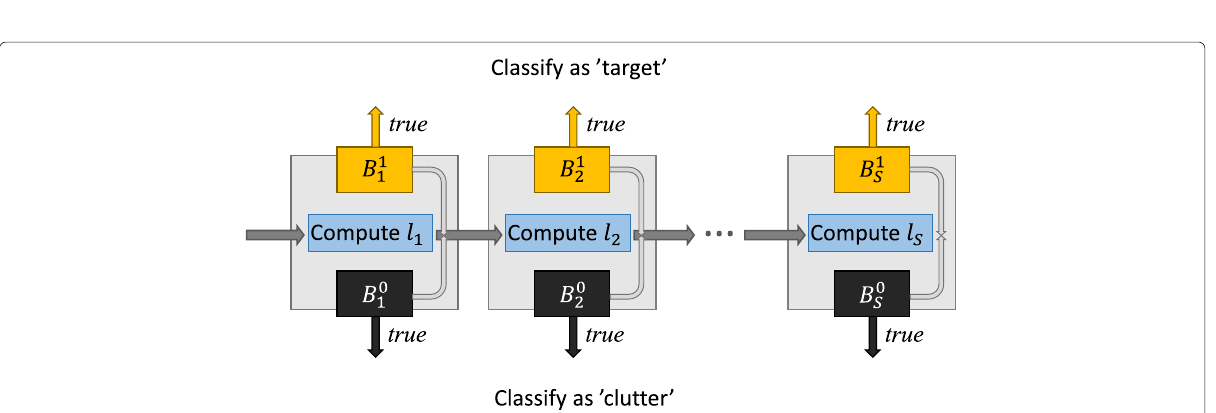
Fig. 3 BOA cascade. Classification process with BOA classification cascade. At each stage s of the cascade new target likelihood score f s ( x ) = l s is computed and either classification is made, or next stage is entered. The internal Boolean decision makers B 1 1 , B 1 2 , ..., B 1 are partitions of function (7), and B 0 1 , B 0 2 , ..., B 0 S